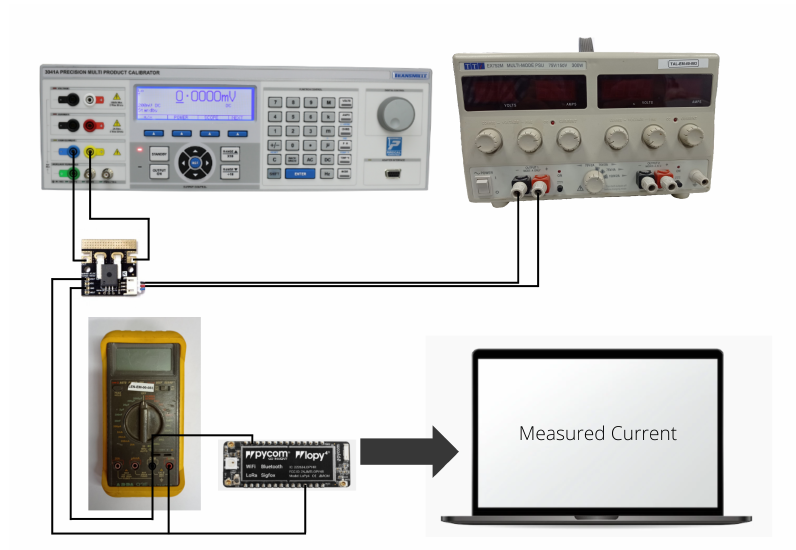
Figure 2. Current sensor calibration assembly: Transmille 3000A Series calibrator, ammeter, regulated power supply and current sensor.